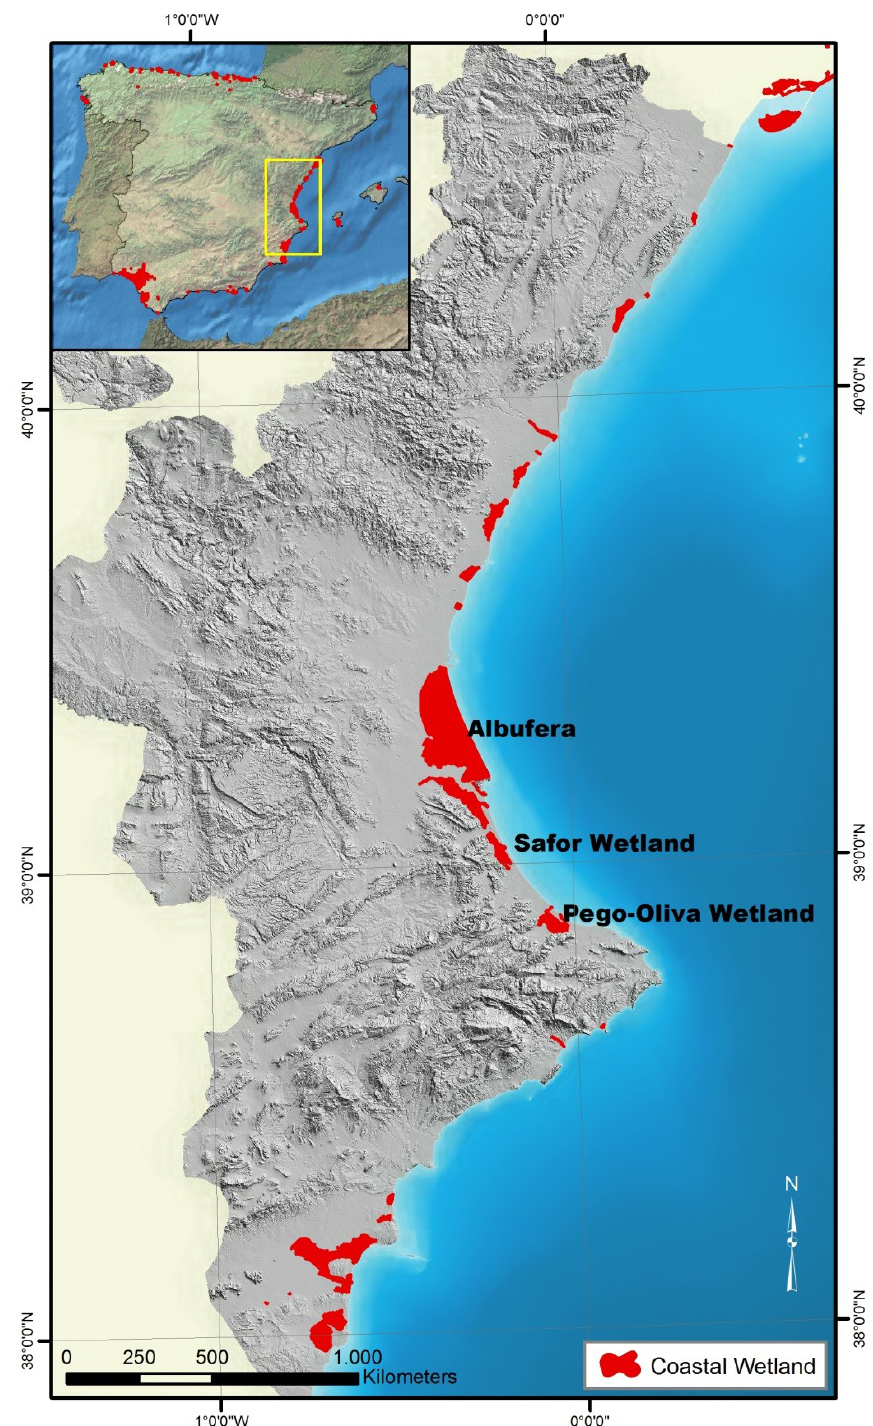
Figure 1. Pego-Oliva Wetland and La Safor Wetland location on the Spanish Mediterranean coast. All coastal wetlands of the Iberian Peninsula are